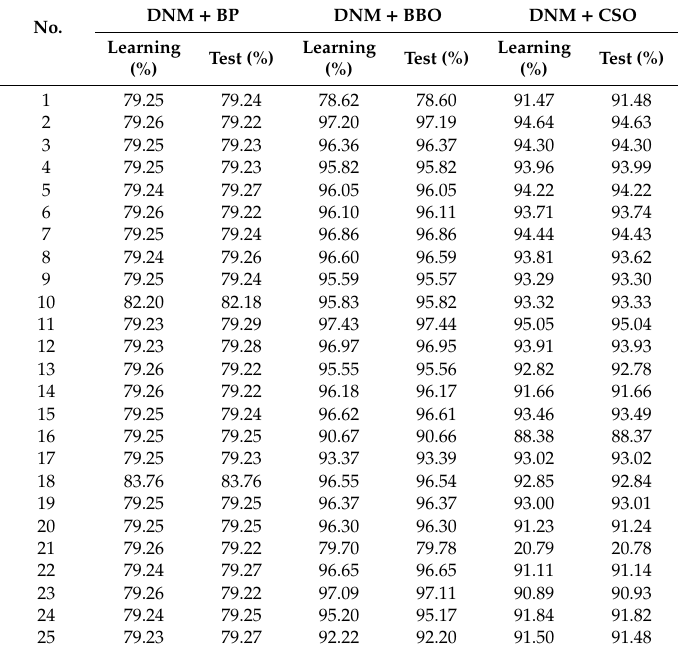
Table A3. Average accuracy of the learning and tests of each learning algorithm in